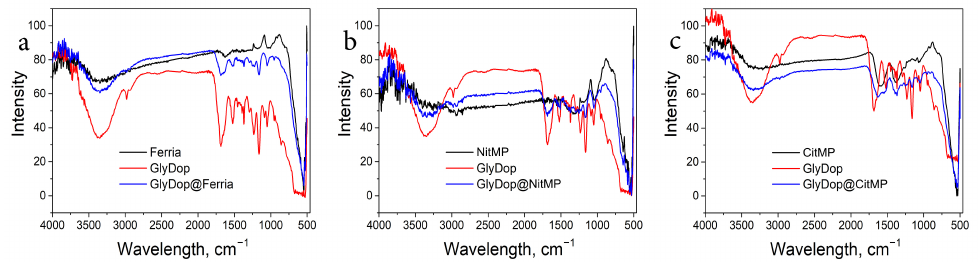
Figure 4. FTIR spectra of Ferria ( a ), NitMP ( b ), and CitMP ( c ), and the corresponding composites with GlyDop.